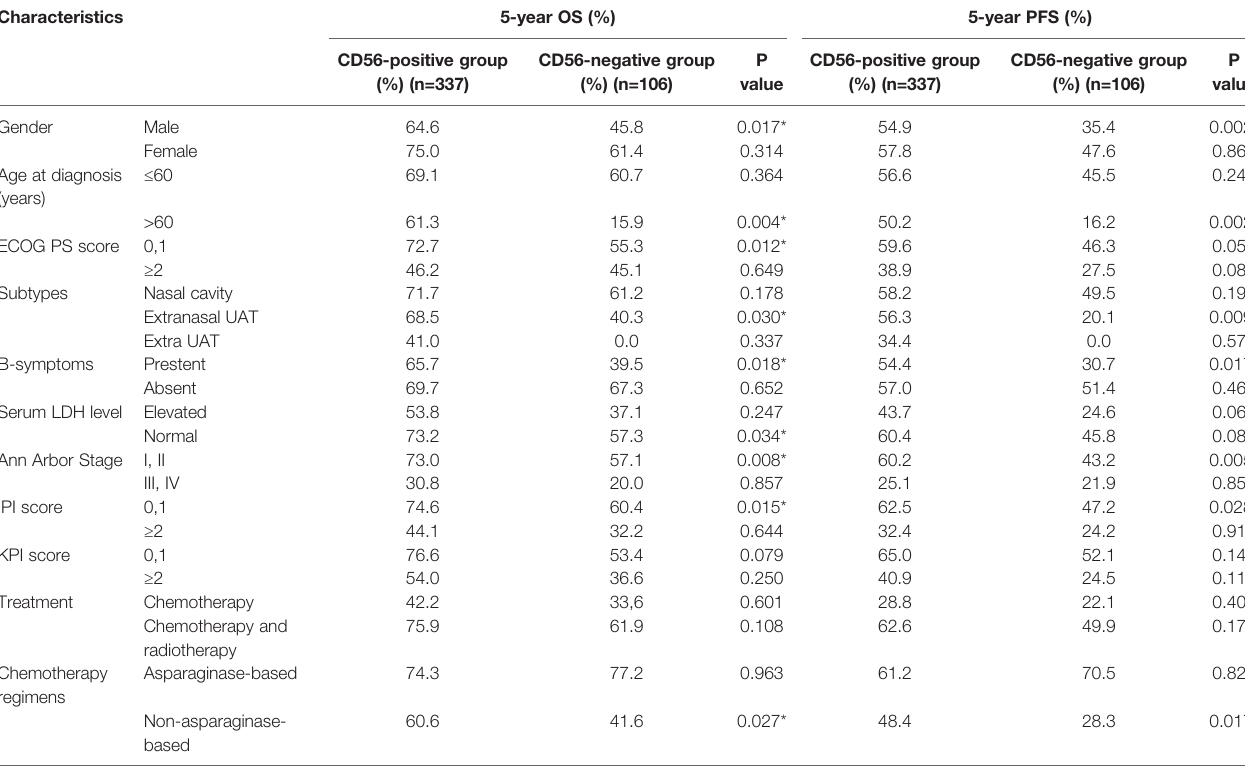
TABLE 2 | Treatment outcomes of patients with CD56-positive vs. CD56-negative NKTCL. Characteristics